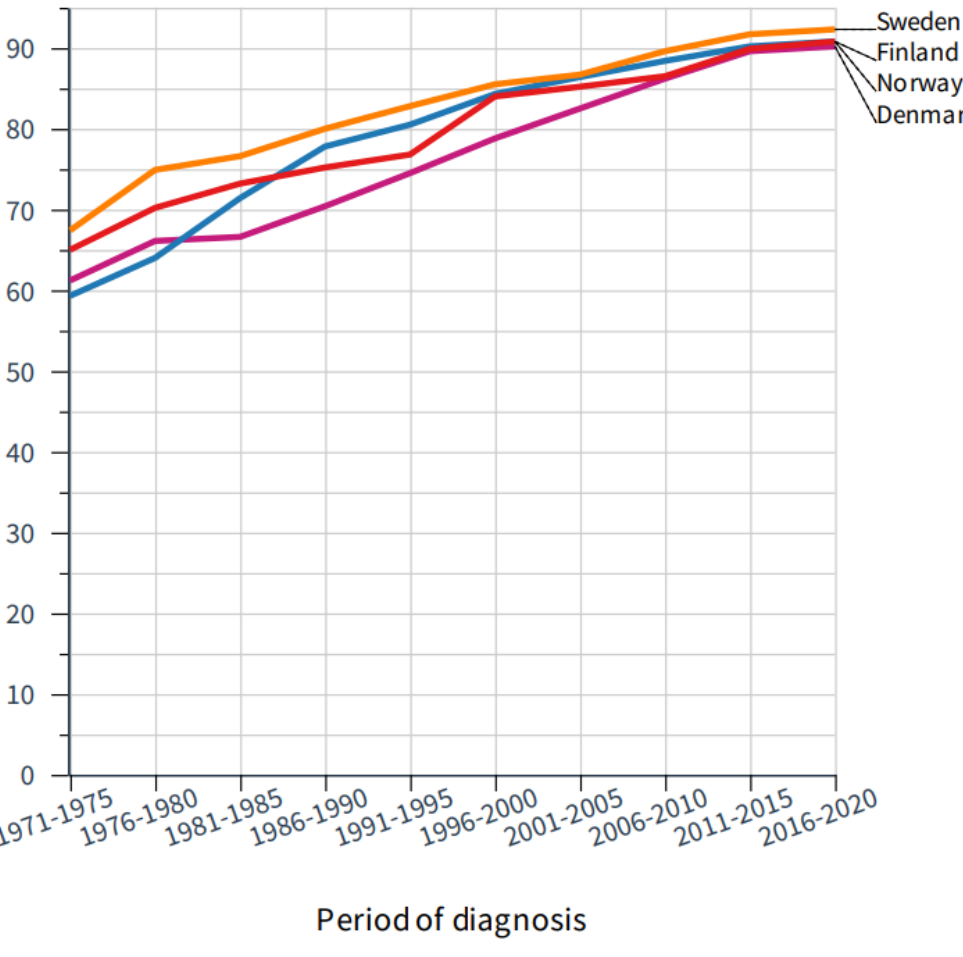
Figure 3. Improvement in 5-year relative survival in female breast cancer in the Nordic countries through 50 years. Table 1. Breast cancer relative survival (%, [95% confidence interval]) in the Nordic countries.